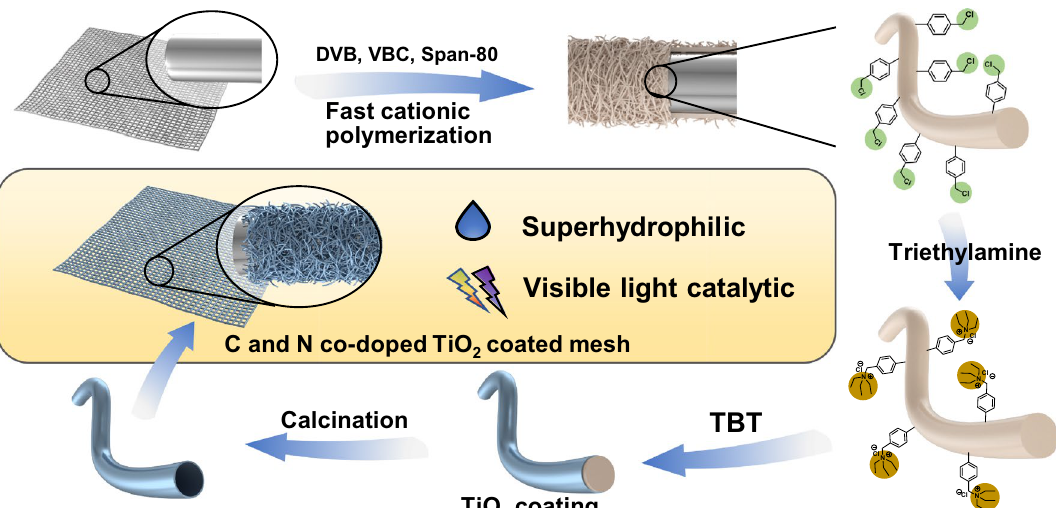
Figure 1. Schematic preparation of the C,N co-doped TiO 2 hollow nanofibers coated